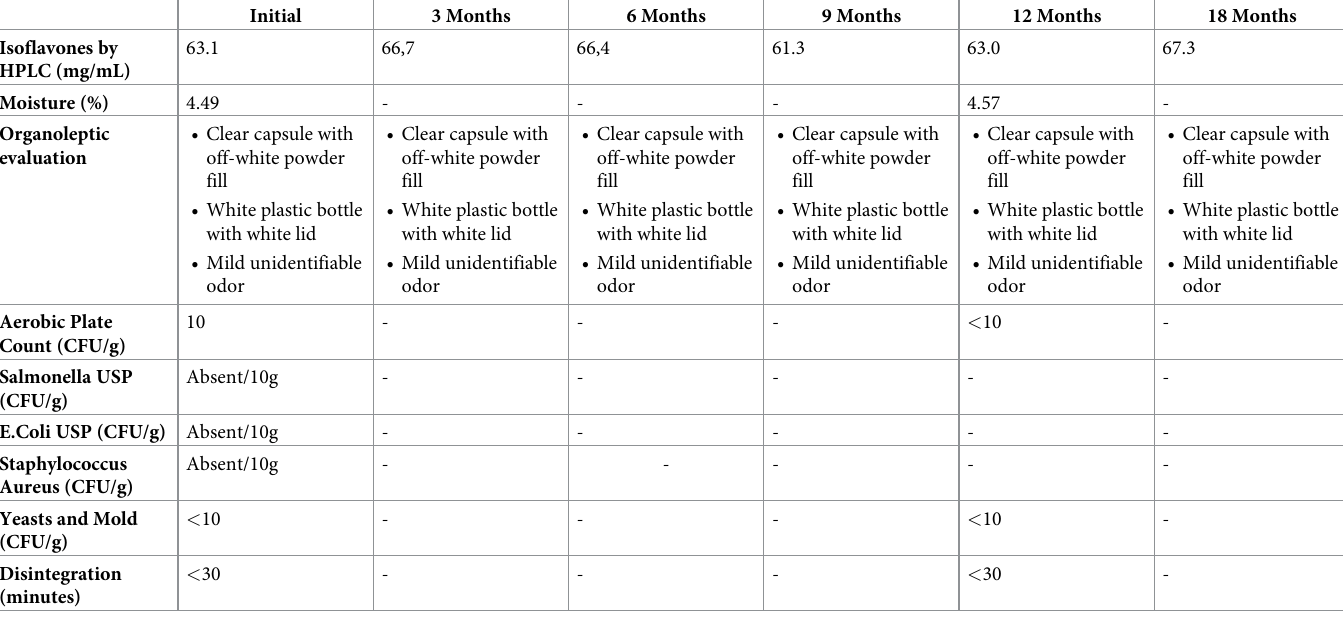
Table 9. Brief summary of the results of real time stability testing (25˚C/ 75%